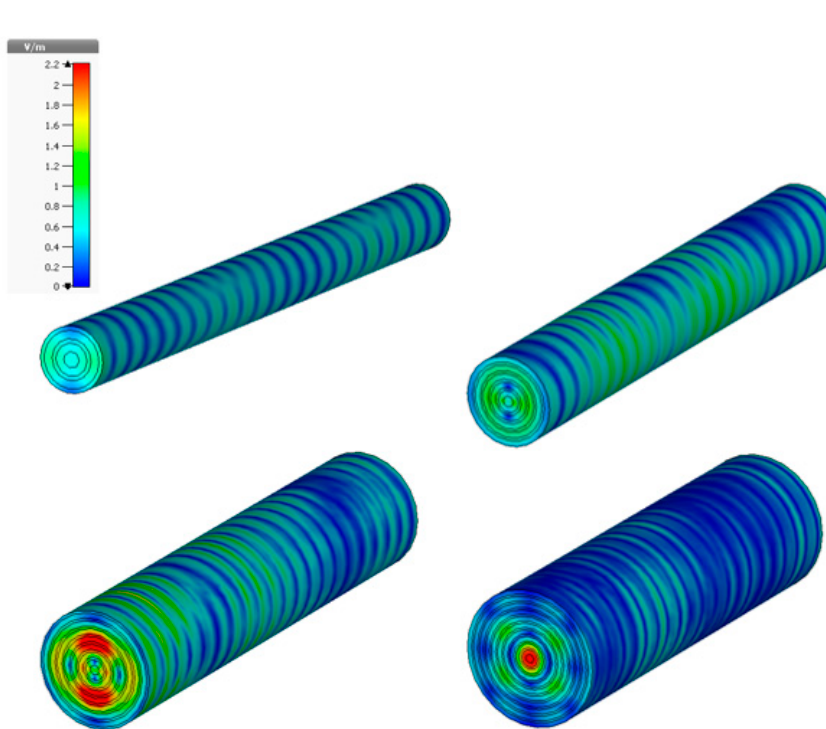
Figure 10. Electric field distribution inside wet poplar wood with different values of the number of growth rings with 100% permittivity variation at 3 GHz. The dielectric constant values considered are the same as the Figure 8.